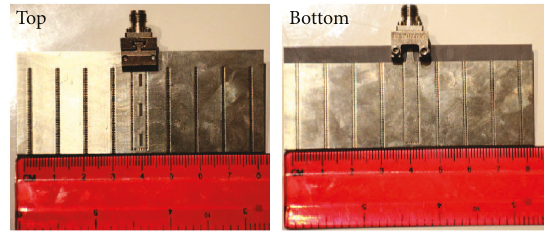
Figure 6: Fabricated antenna.